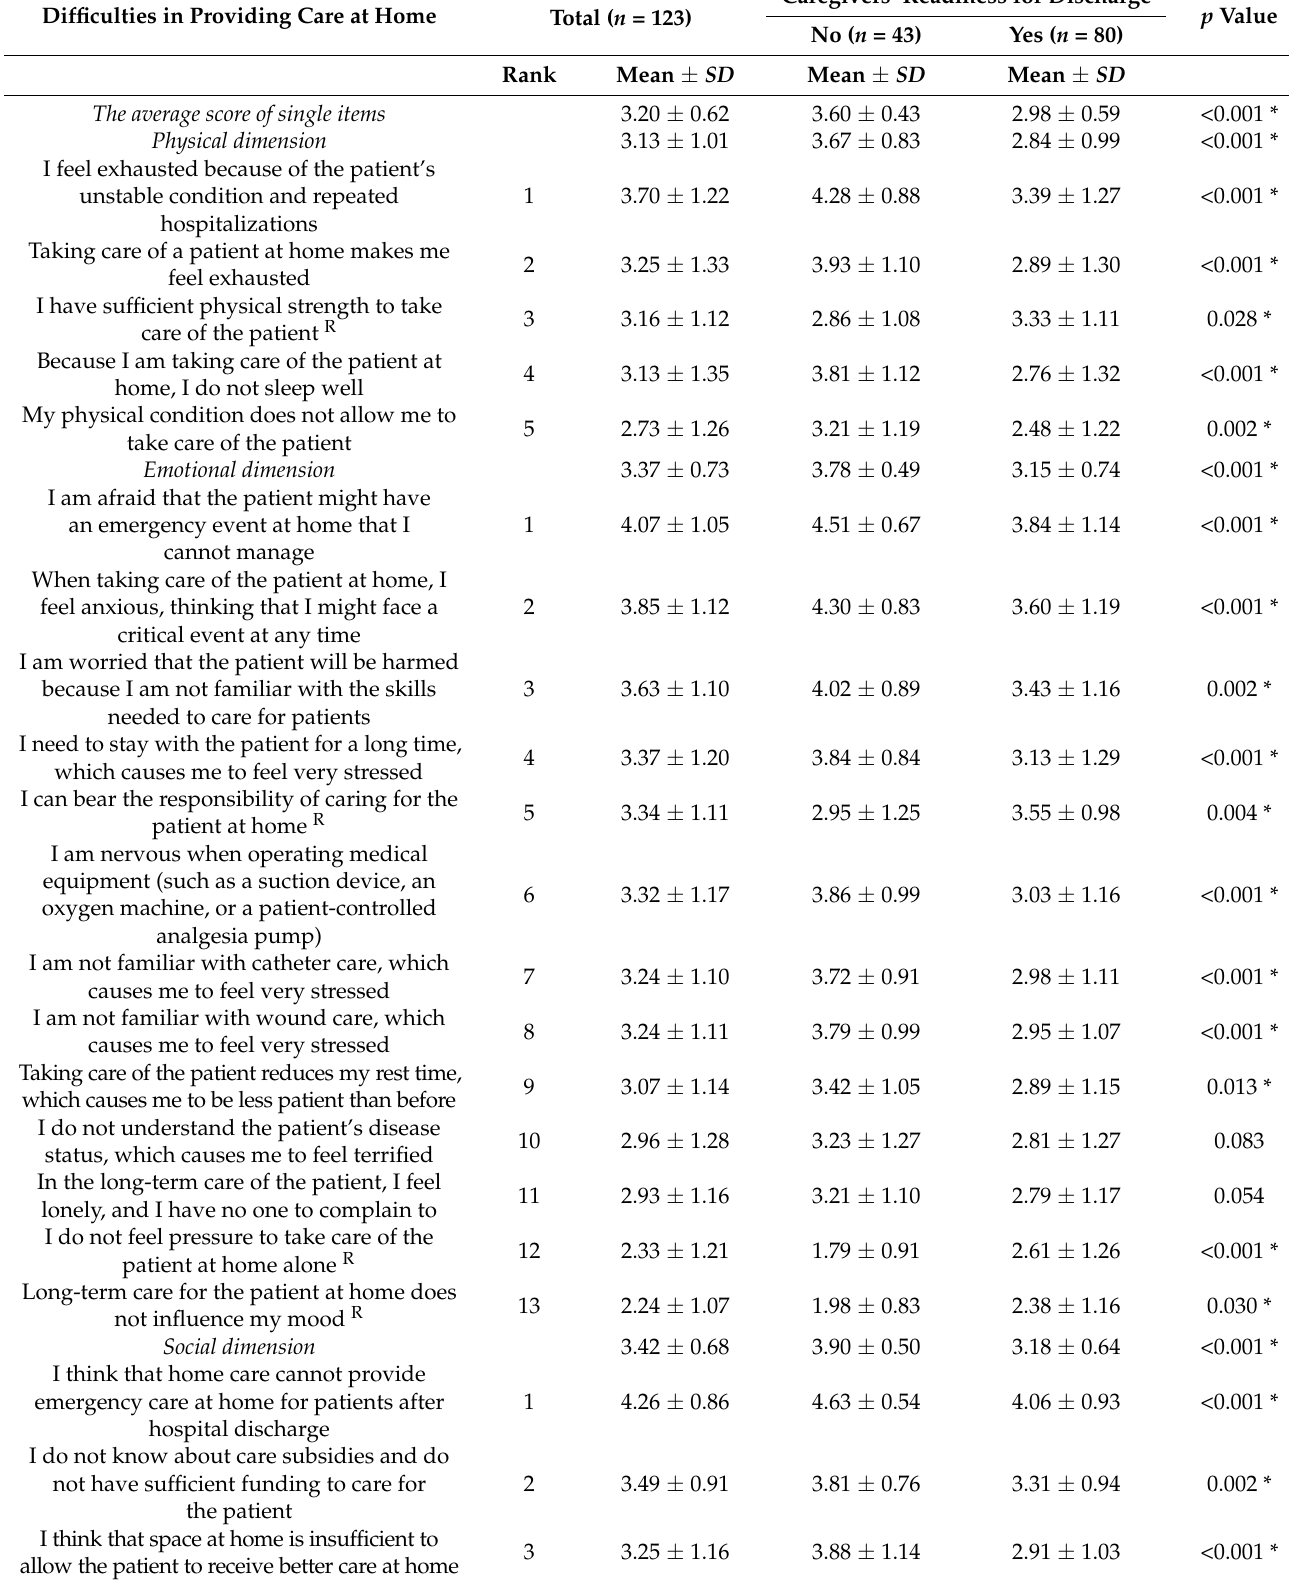
Table 2. Difficulties in providing in-home care and family caregivers’ readiness for